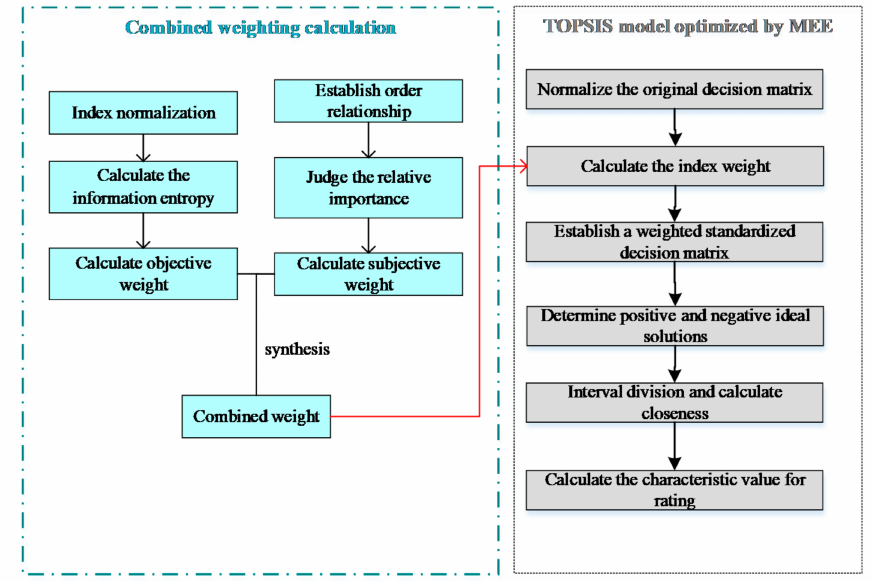
Figure 3. The process of comprehensive benefit evaluation model of the